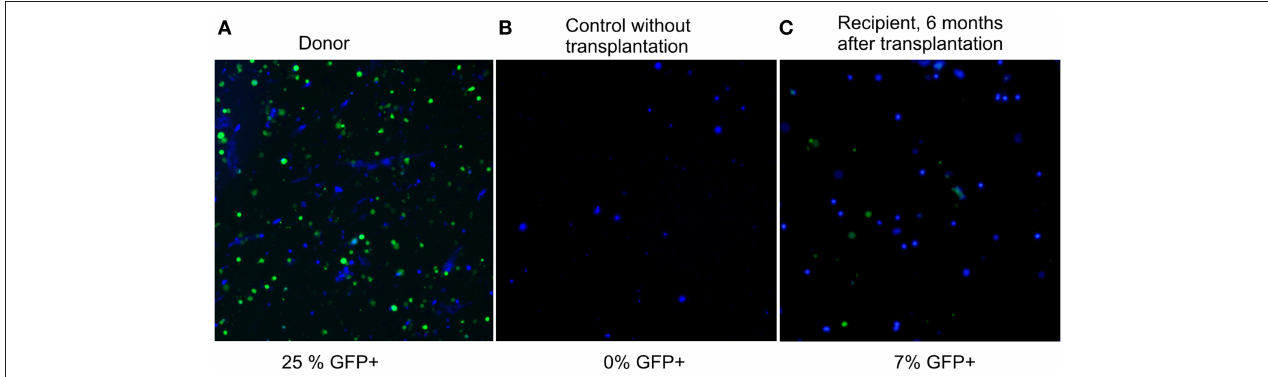
FIGURE 2 | Fluorescence images of preparations of bone marrow suspension of donor, control, and transplanted mice. Overlay of fluorescence microphotographs at 380nm (nuclei stained by NucBlue, shown in blue here), and 485nm (GFP + , shown in green). Cellinsight CX7, magnification 200X. (A) donor BM, the content of nucleated GFP + cells is 25%; (B) BM of a control GFP-mouse without transplantation, the content of nucleated GFP + cells is 0%; (C) BM of a recipient 6 months after transplantation, the content of nucleated GFP + cells is 7%.